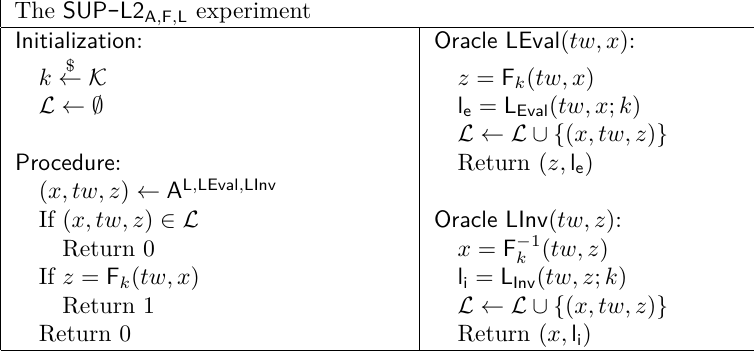
Table 3: Strong unpredictability with leakage in evaluation & inversion.